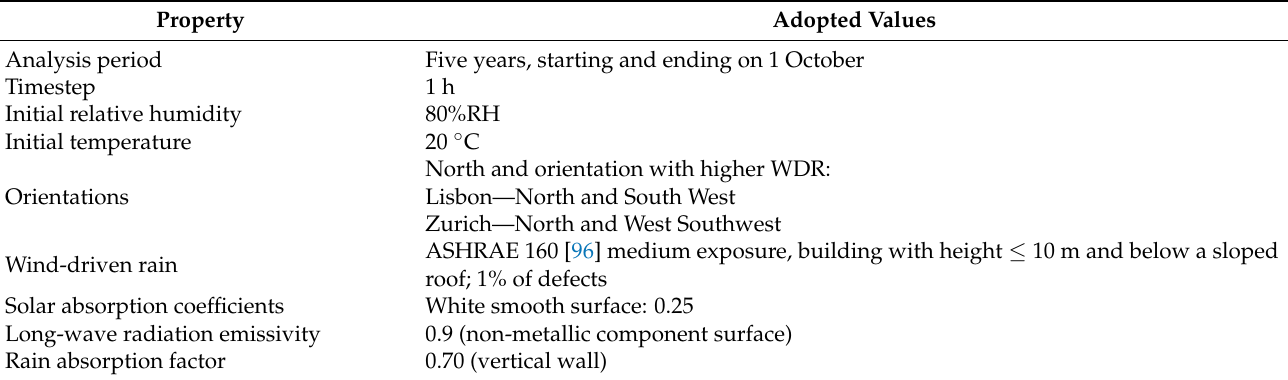
Table 6. Simulation boundary